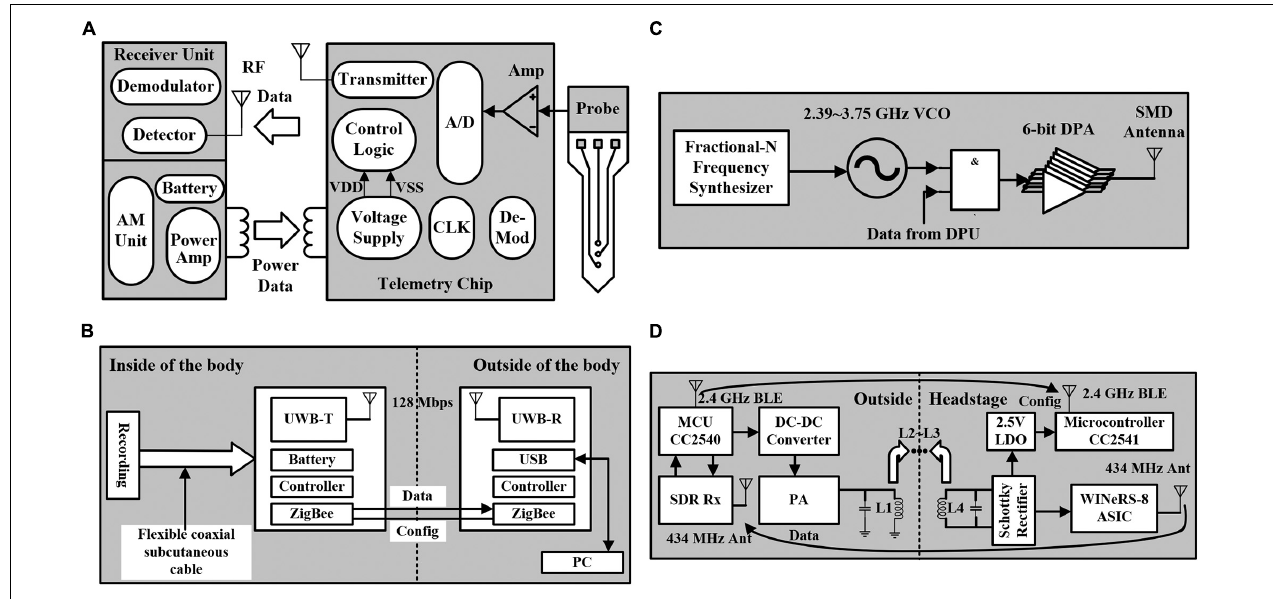
FIGURE 6 | (A) Traditional structure of the wireless powered neural recorder. (B) Block diagram of the neural recorder using the UWB transmitter for BMI. (C) The block diagram of an energy-efficient wireless transmitter using dual-band on–off keying modulation. (D) The block diagram of the four-coil inductively powered wireless neural recording and stimulation